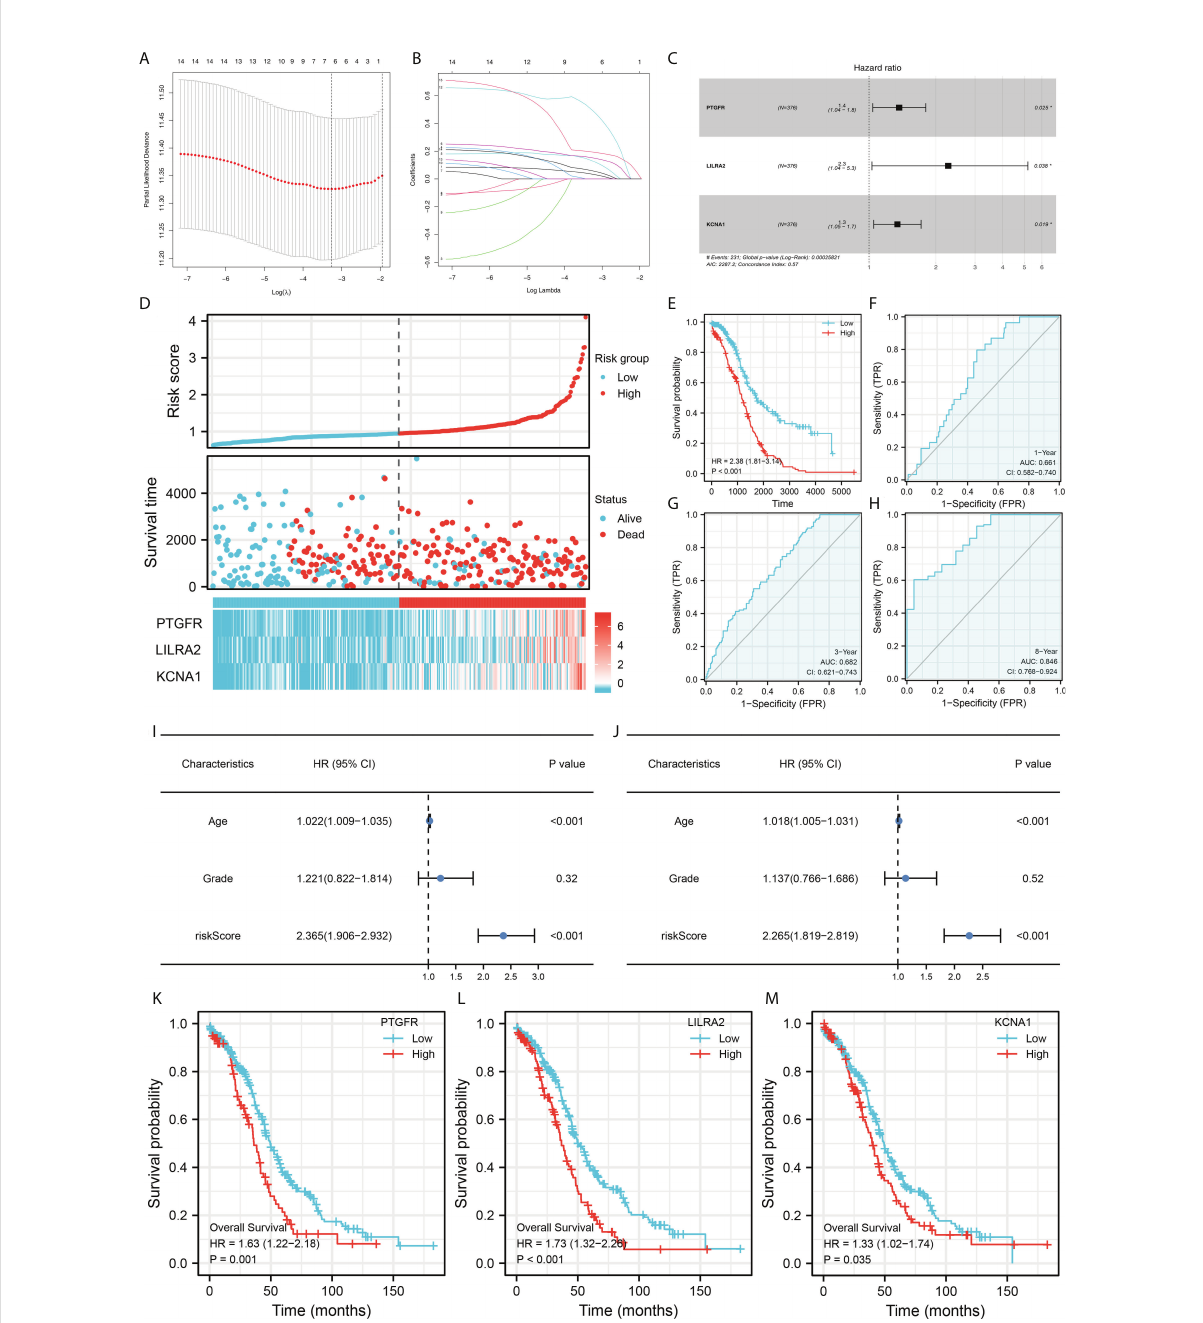
FIGURE 3 Construction of the prognosis model. (A, B) LASSO regression was used for dimensionality reduction; (C) Multivariate Cox regression analysis identi fi ed three genes for prognosis model construction, including PTGFR, LILRA2 and KCNA1; (D) Overview of the model in training cohorts; (E) Kaplan-Meier survival curves of patients in high and low risk group in the training group; (F – H) ROC curves of the 1-, 3- and 8-year survival; (I – J) Univariate (I) and multivariate (J) analysis were performed to evaluate the independence of our model; (K – M) Kaplan-Meier survival was performed to explore the prognosis role of model genes in overall